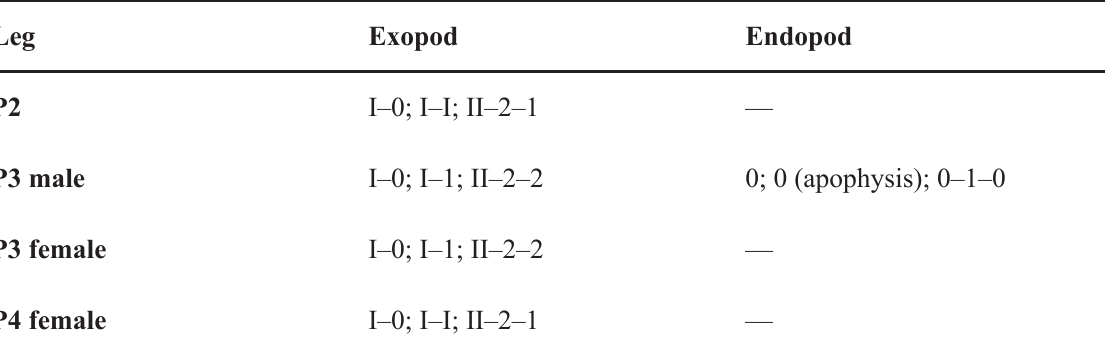
Table 1. Poropsyllus menzelae gen. et sp. nov., setation of swimming legs P2–P4; Roman numerals indicate outer, Arabic numerals inner